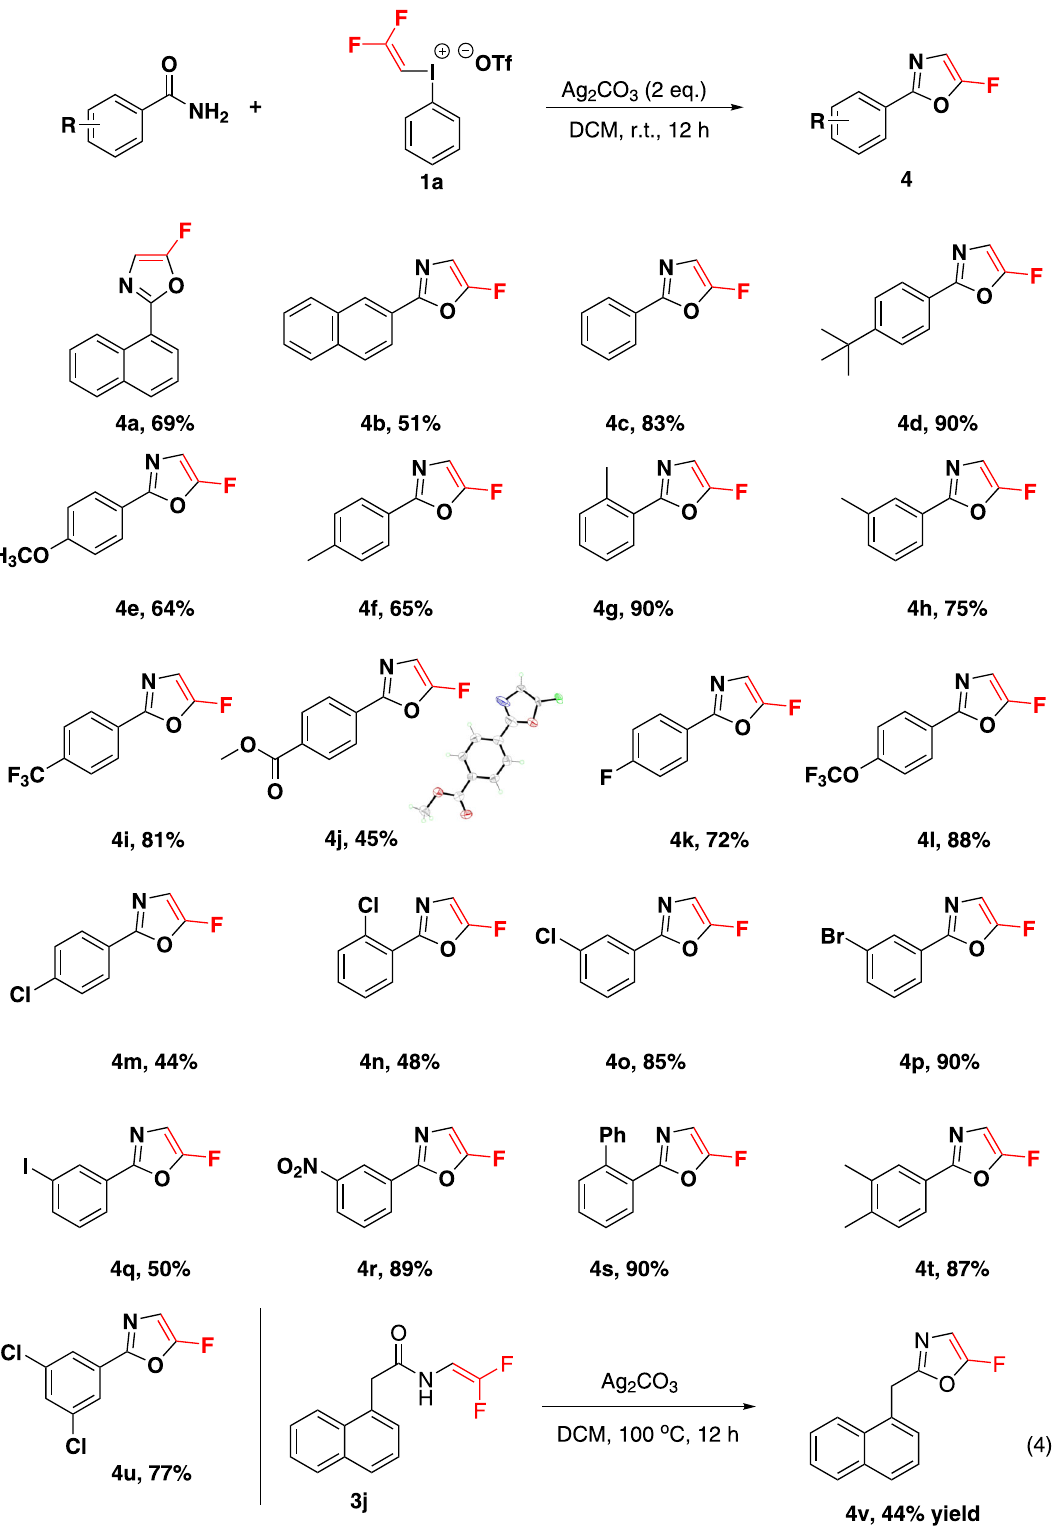
Fig. 6 Electrophilic fl uorovinylation of amide. Reaction conditions: amide (0.2 mmol), 1a (0.24 mmol), Ag 2 CO 3 (0.4 mmol) in CH 2 Cl 2 (2.0 ml) at room temperature for 12 h. Yields shown are of isolated products. CCDC No.: